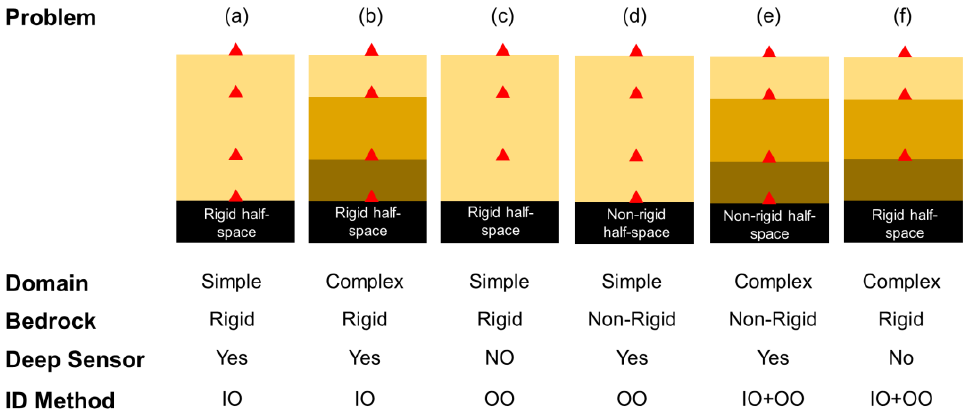
Figure 3. Various possible problem cases and proposed solution approaches. IO and OO represent the input-output and output-only identification methods, respectively.